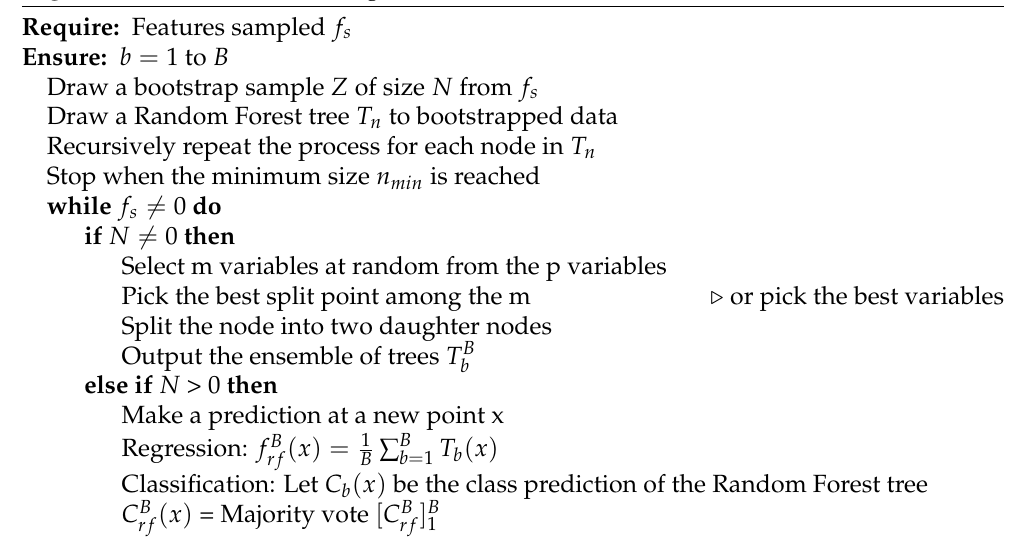
Algorithm 1 Random Forest